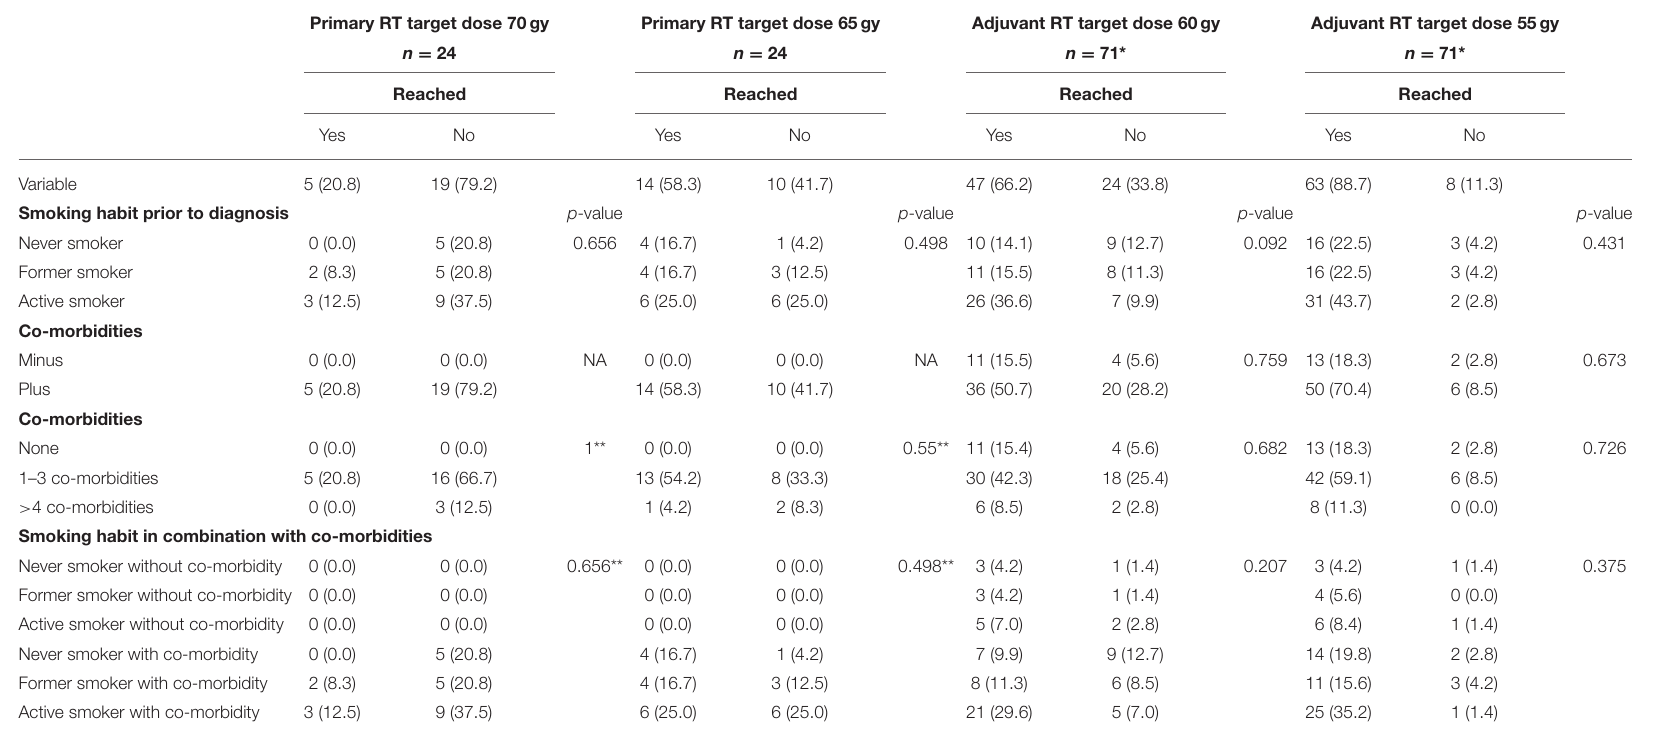
C: Reaching the target dose during either primary or adjuvant